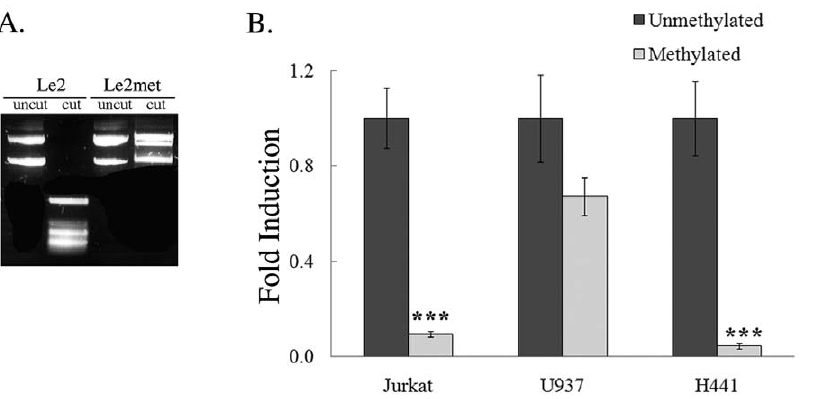
Figure 6. Methylation of CpG sites in the vav 1 promoter impairs expression of the reporter gene in various cell lines. (A) Le2 plasmid, either un-treated or methylated by CpG methyltransferase (M.SssI), was incubated with HpaII and analyzed on a gel. The plasmid treated with M.SssI was not digested by HpaII, indicating that methylation was successful. (B) Unmethylated or methylated Le2 was transfected into Jurkat T cells, U937 myeloid cells and H441 lung cancer cells. The luciferase activity of these plasmids was measured 24 hr after transfection. Fold induction of luciferase activity was calculated relative to the activity in cells transfected with unmethylated Le2. Each point is the mean of three experiments. (***) indicates p , 0.01, unpaired student T test.